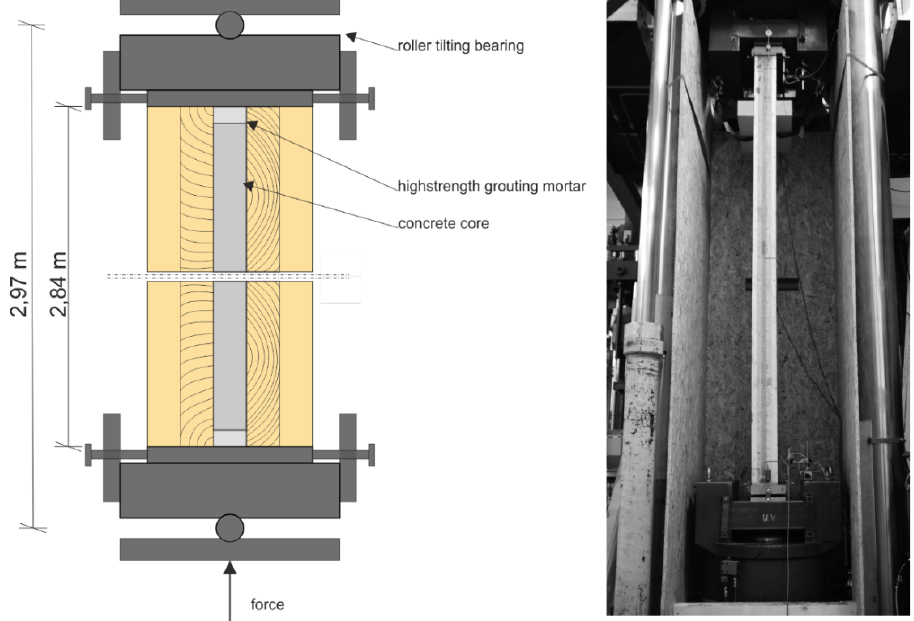
Figure 7. Schematic (left) and real (right) experimental test setup for full scale tests